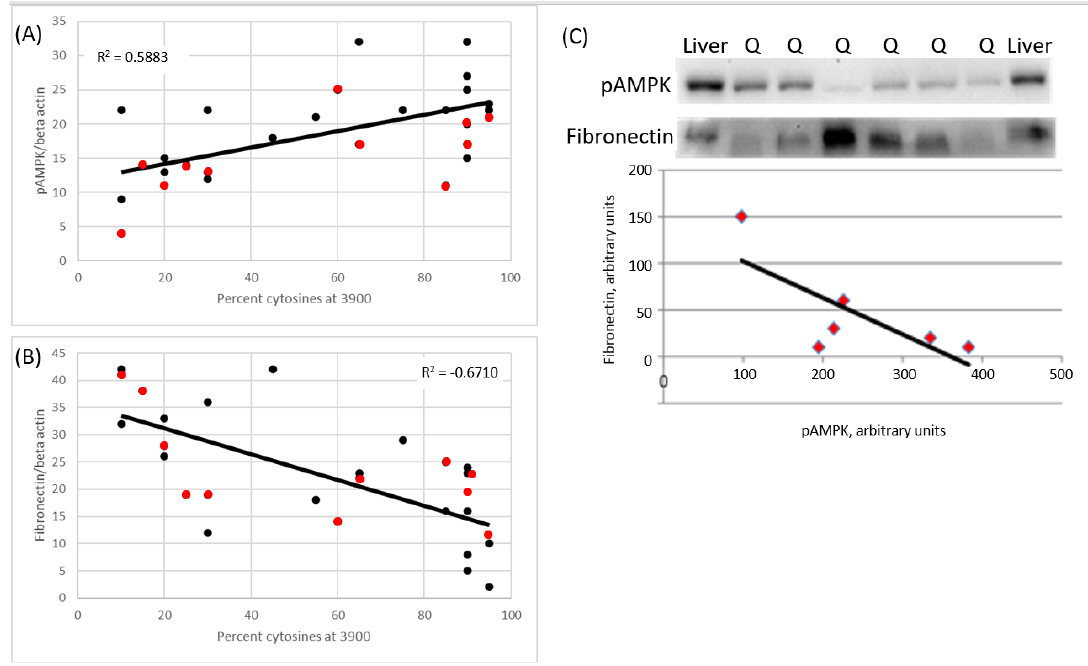
Figure 6. The cytosine mutation at nucleotide 3900 segregates with molecular markers of decreased fibrosis. Both lines of mice with variable MRL mitochondria show the significant ( p < 0.05) positive correlation of the percentage of cytosines to pAMPK, normalized for beta actin ( A ), and the significant ( p < 0.05) inverse correlation of the percentage of cytosine and fibronectin protein, normalized for beta actin ( B ). Nuc D Mito %M in red and Nuc M Mito %M in black. Representative blots of pAMPK and fibronectin. The center lanes are quadriceps from a single litter of Nuc M Mito %M mice. The flanking lanes contain control liver samples used to quantify between blots. The blot was stripped between each primary antibody blot. This blot demonstrates a significant ( p < 0.05) negative correlation between pAMPK and fibronectin protein (both normalized for beta actin) ( C ).